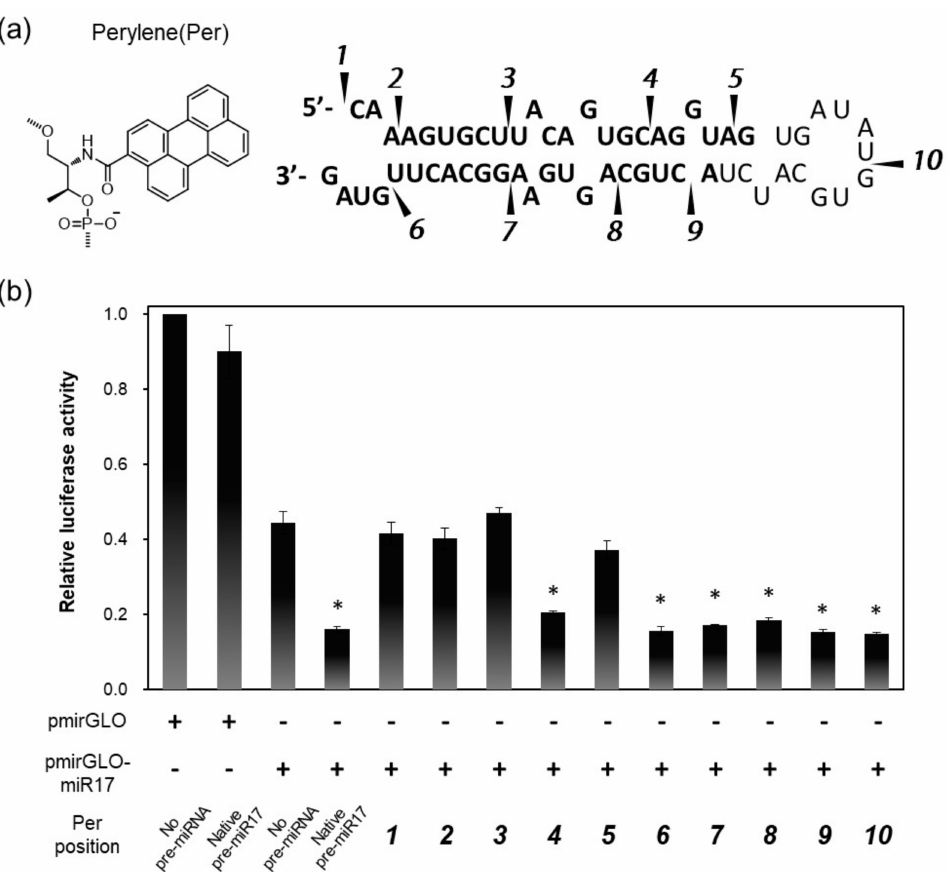
Figure 1. Design and RNAi activities of Per-modified pre-miR17: ( a ) Chemical structure of Per that was inserted into pre-miR17. The Per modification positions are shown as indications. ( b ) RNAi activities in the HeLa cells that were transfected with plasmid possessing a luciferase coding region (pmirGLO) or plasmid possessing an miR17 binding site (pmirGLO-miR17) and pre-miR17 are shown. The positions of Per in each pre-miR17s are indicated by the numerals. The plasmid and pre-miR17 (30 nM) were transfected into the Hela cells. The luciferase activity of the cells that were transfected with pmirGLO was set to 1.0. Plotted are means and SD (n = 3) of firefly/ Renilla luciferase signal relative to the untreated sample. * p < 0.001 vs. no